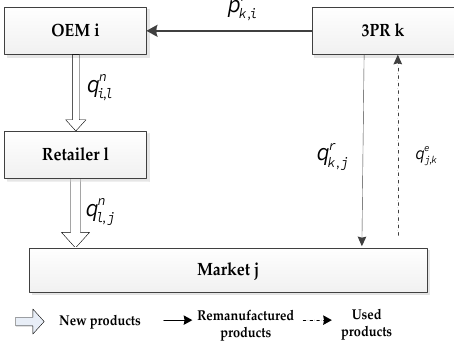
Figure 4. The transaction diagram of the ARS model.